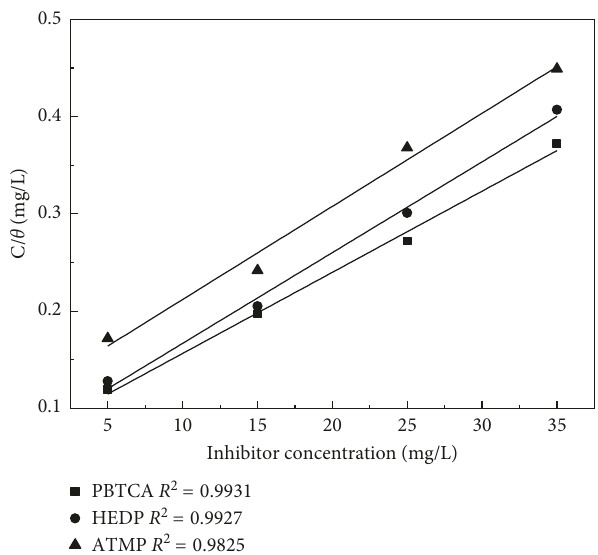
Figure 7: Isotherm fitting of three organic phosphorus inhibitors to Langmuir